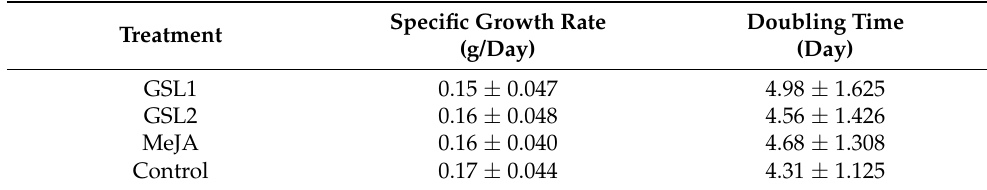
Figure 2. The dry weight of A. malaccensis callus after treatment with F. solani strain GSL 1 or GSL2, or MeJA or control untreated callus. No significant differences were observed between treatments ( p -value > 0.05, n = 3). Table 1. Average relative growth rate and doubling time of the A. malaccensis callus treated with F. solani strain GSL 1 or GSL2 mycelium, or MeJA, or control untreated callus. No significant differences were observed between treatments ( p -value > 0.05, n = 3).